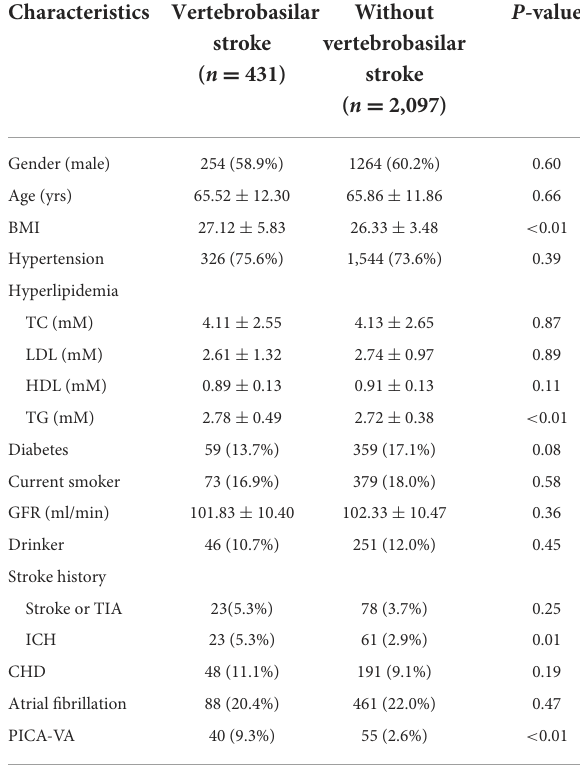
TABLE 1 Characteristics of stroke patients with or without PICA-VA. Characteristics Patients with